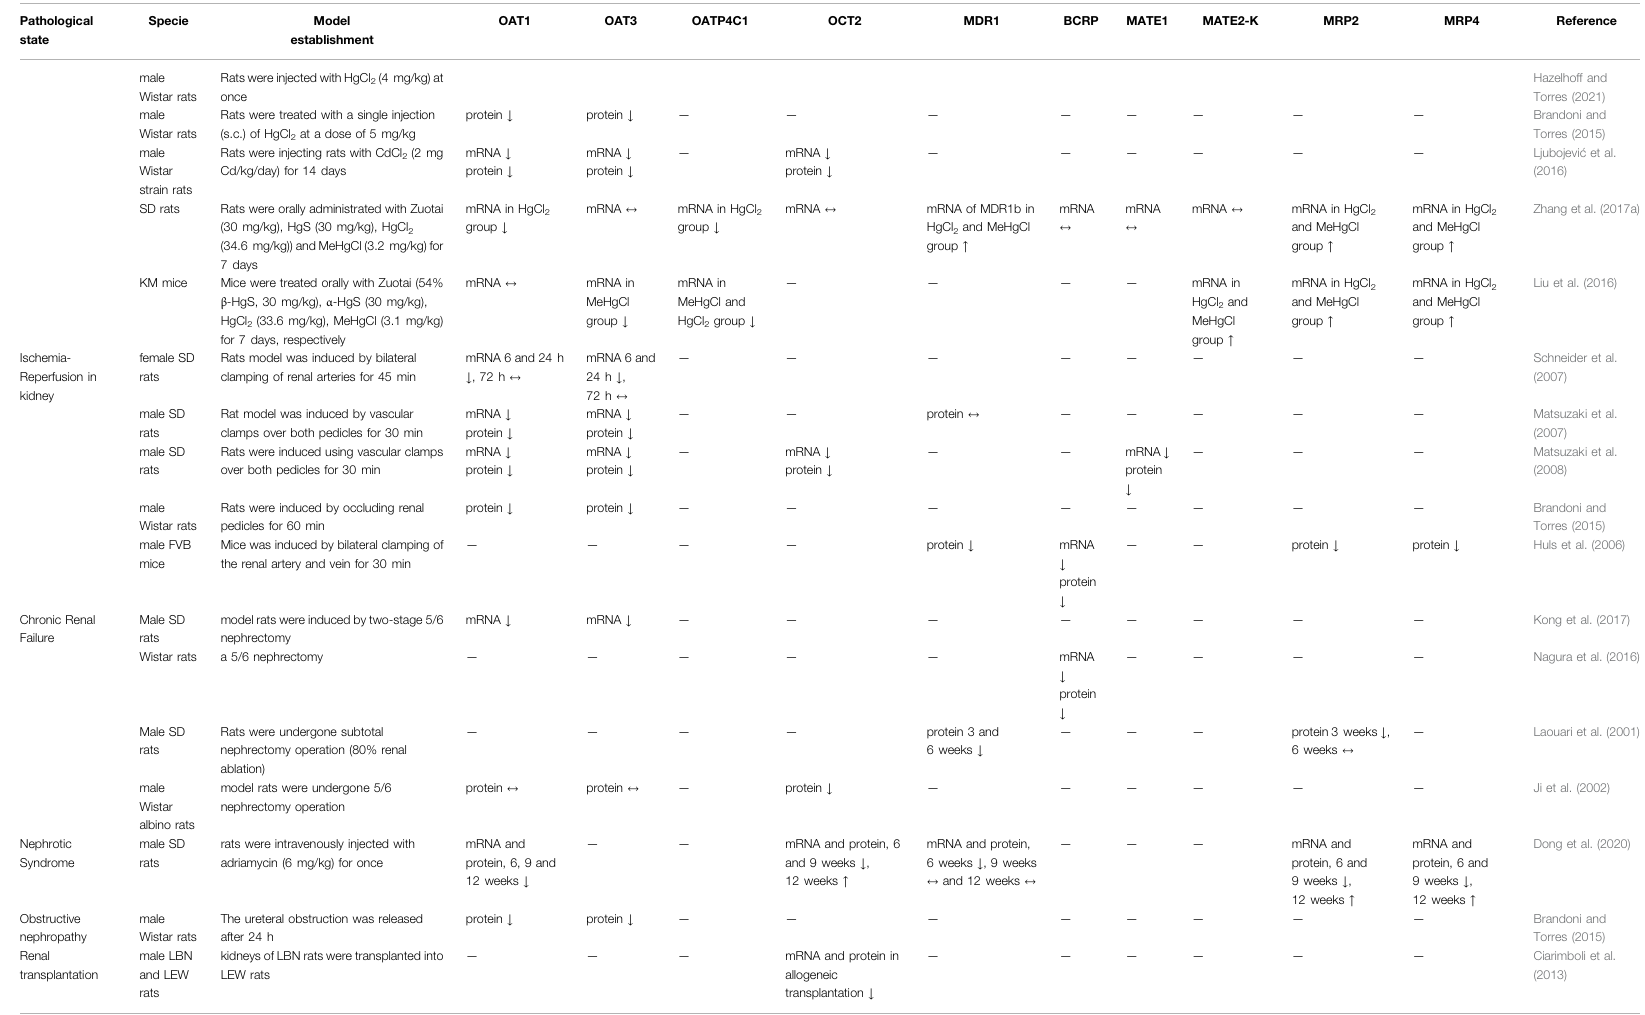
Nephrotic male SD rats were intravenously injected with Syndrome rats adriamycin (6 mg/kg) for once Obstructive male The ureteral obstruction was released nephropathy Wistar rats after 24 h Renal male LBN kidneysofLBNratsweretransplantedinto transplantation and LEW LEW rats rats SDrats:Sprague-Dawleyrats;KMmice:kunmingmice;FVBmice:FriendleukaemiavirusBstrainmice;LBNrats:lewisbrownnorwayrats;LEWrats:lewisrats; ↓ :decreaseinexpression; ↑ :increaseinexpression; ↔ :nosigni fi cantdifference; /: not